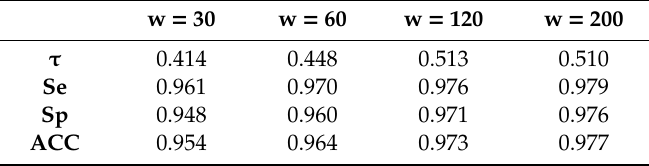
Table 1. Threshold, specificity, sensitivity, and accuracy for window size 30, 60, 120 and 200.